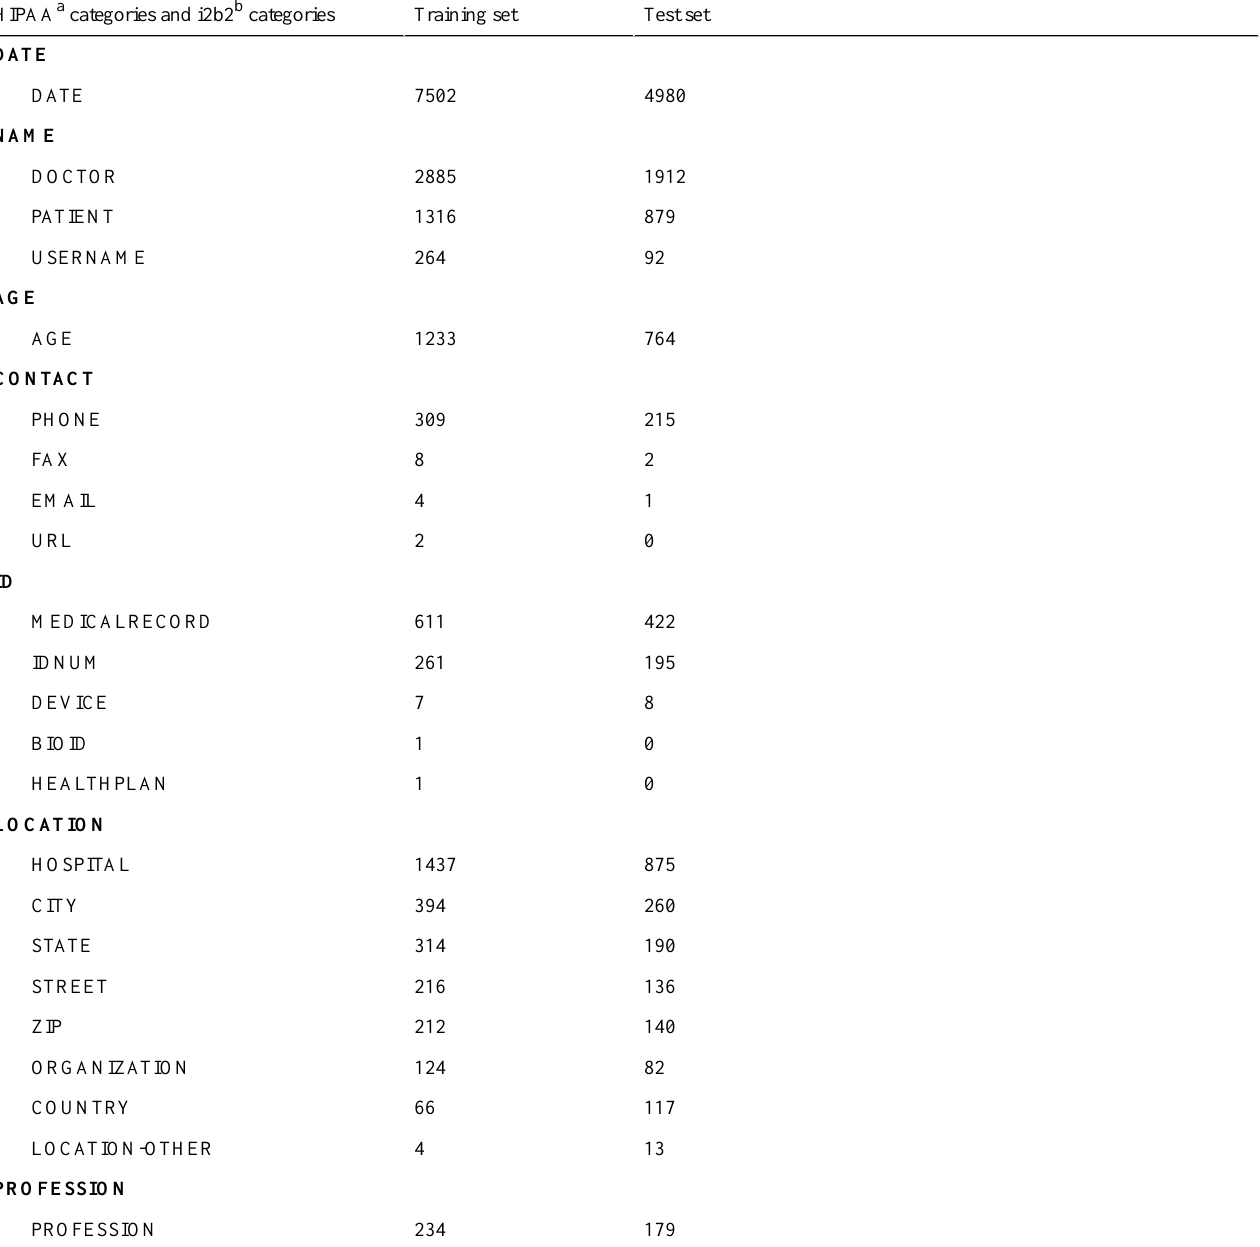
Table 2. Protected health information (PHI) distribution in the 2014 i2b2 deidentification corpus (total PHI in training set=17,405 and total PHI in test